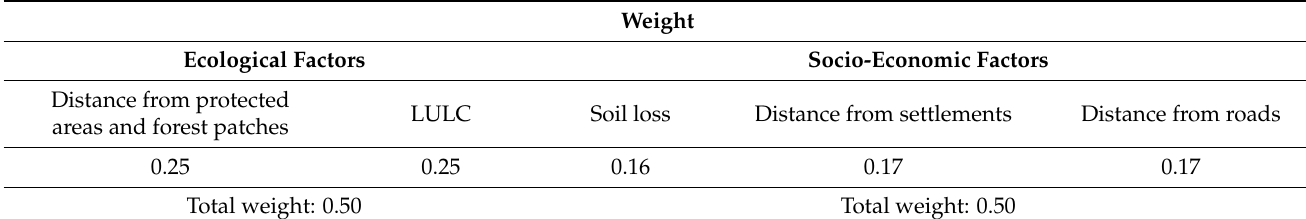
Table 5. Weight assigned to each group and criteria in assessing the suitability of land in the watershed of